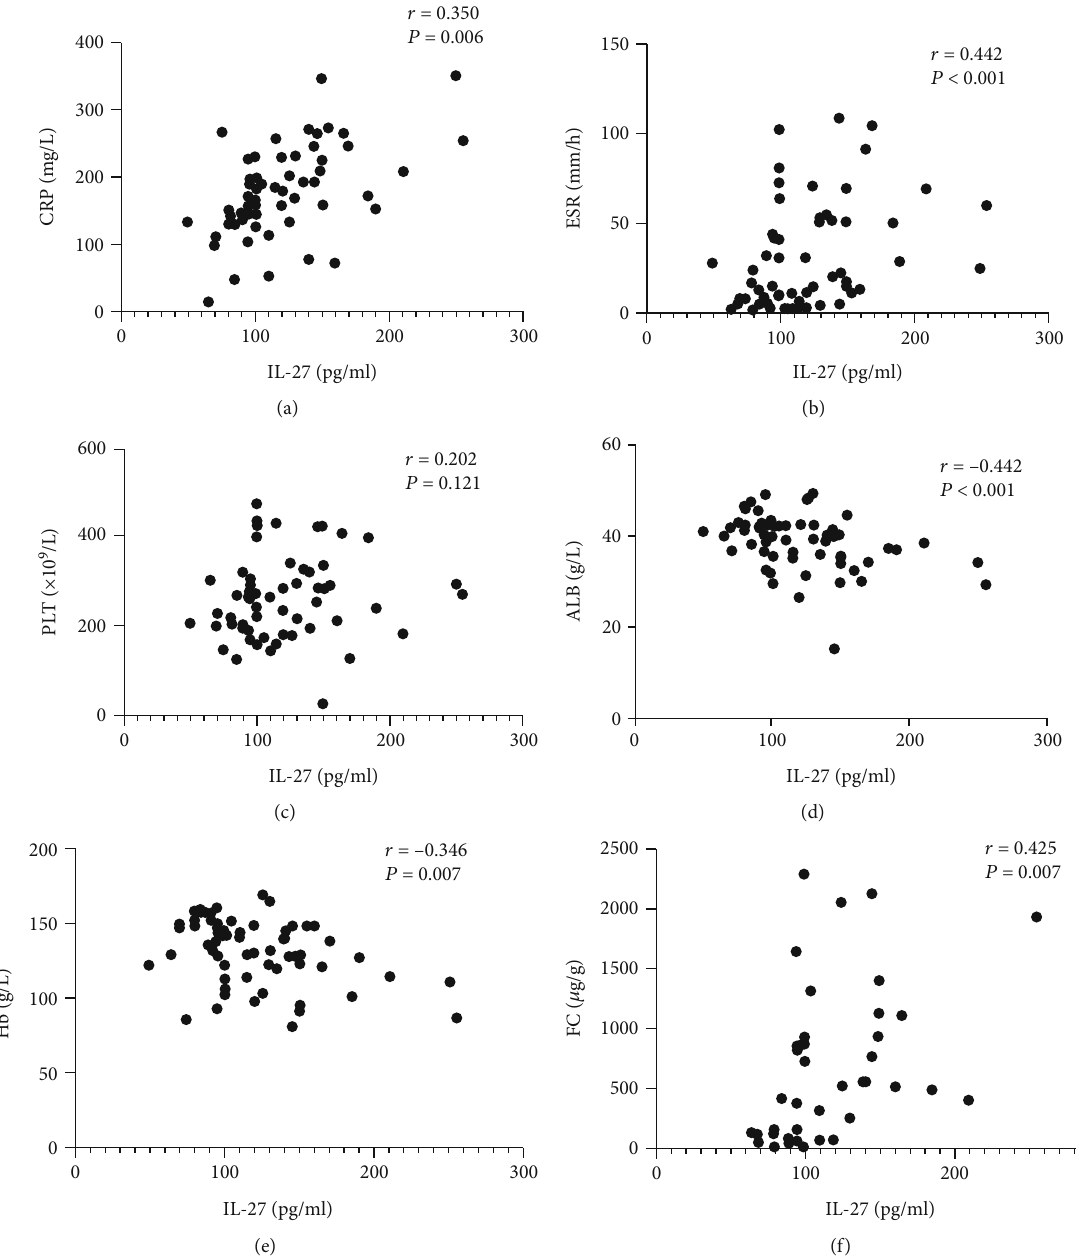
Figure 3: Correlation analysis between serum IL-27 levels and serum and fecal activity parameters in all CD patients ( n = 60 ). (a) Correlation of serum IL-27 levels with C-reactive protein (CRP). (b) Correlation of serum IL-27 levels with erythrocyte sedimentation rate (ESR). (c) Correlation of serum IL-27 levels with platelet (PLT) counts. (d, e) Correlation of serum IL-27 levels with serum albumin (ALB) and hemoglobin (Hb). (f) Correlation of serum IL-27 levels with fecal calprotectin (FC). Spearman ’ s rank correlation test was used to assess the correlations between the di ff erent